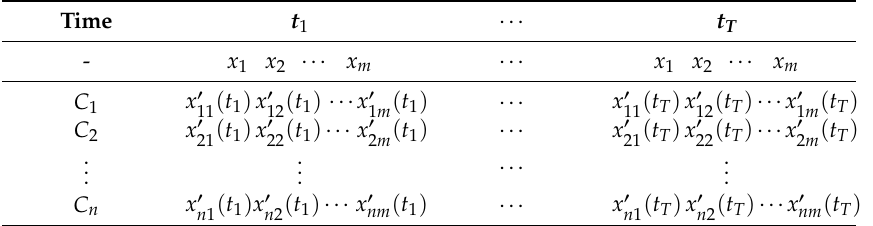
Table 3. Multidimensional time